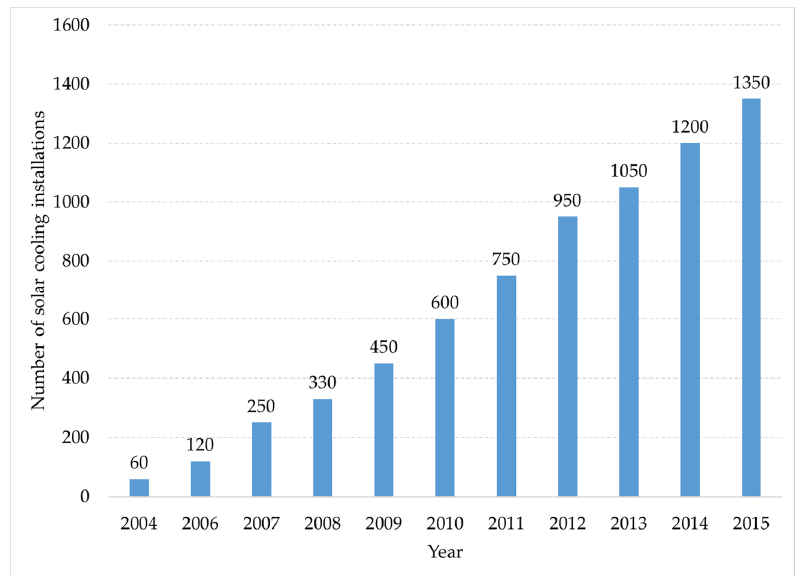
Figure 1. Number of solar cooling installations between 2004 and 2015. Reproduced with permission from [21], Copyright AIP Publishing,